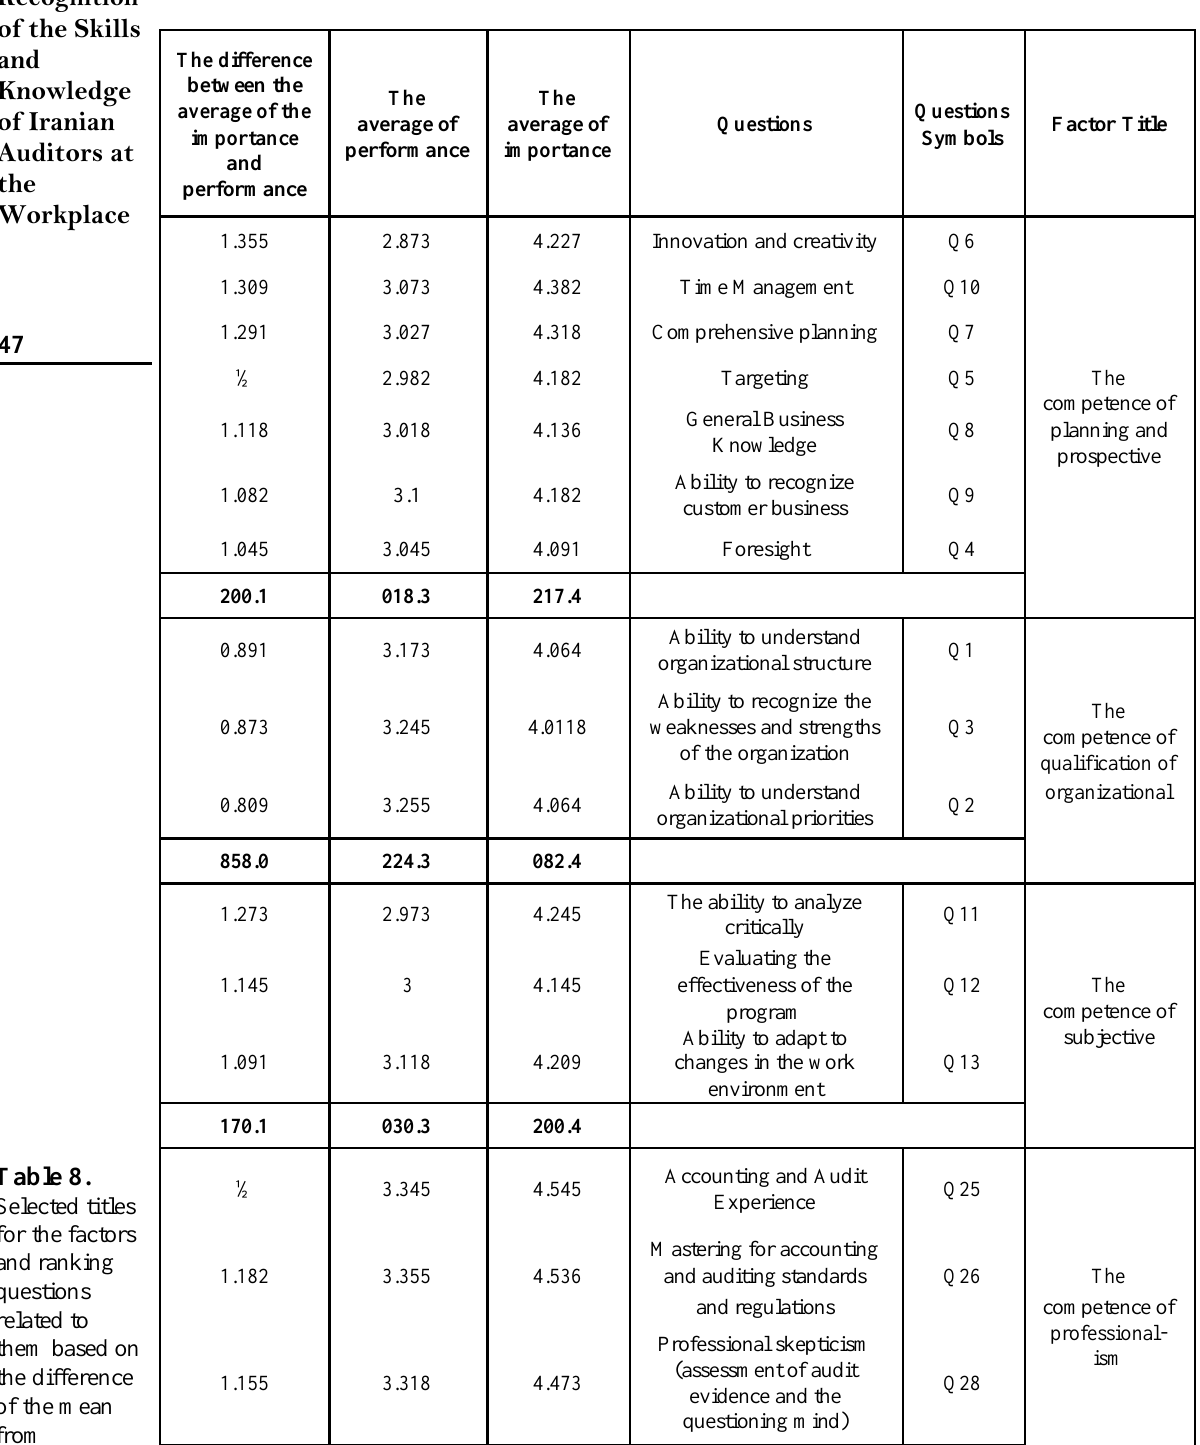
Table 8. Selected titles for the factors and ranking questions related to them based on the difference of the mean from